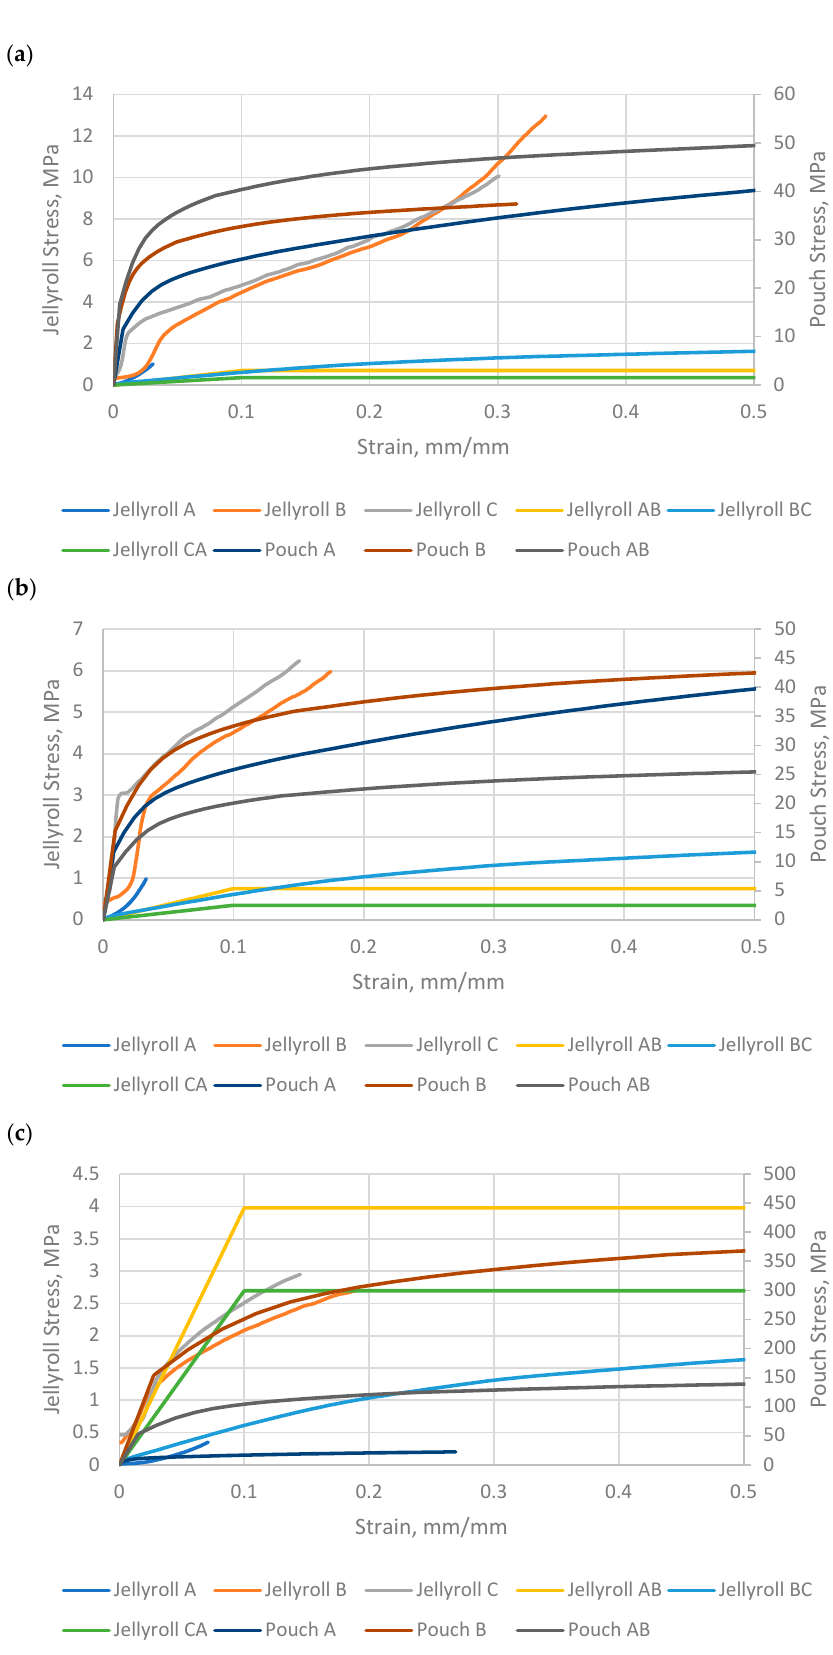
Figure 7. Fitted stress-strain curves for jellyroll and pouch materials for ( a ) DK50106, ( b ) DK80106 Figure 7. Model of Dow Kokam SLPB 50106100 in ( a ) lateral compression, ( b ) confined in ‐ plane and ( c ) DMYCELL. Jellyroll flow curves on left axes, pouch flow curves on right compression and ( c ) three ‐ point bend. Dashed lines indicate pre ‐ test undeformed geometry.